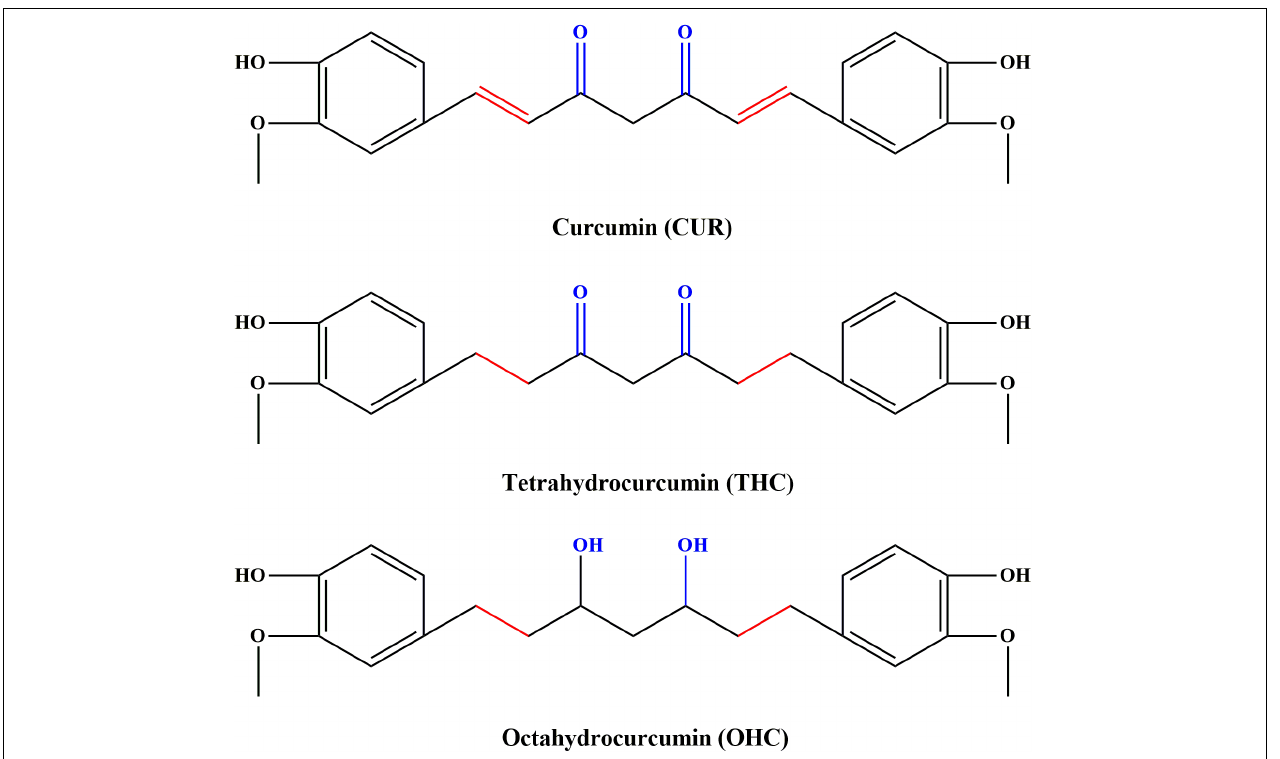
FIGURE 1 | Chemical structures of curcumin (CUR), tetrahydrocurcumin (THC), and octahydrocucumin